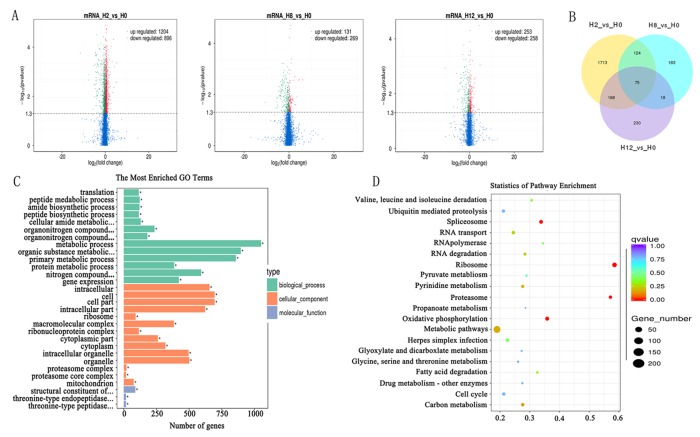
Analysis of mRNA sequencing data. Volcano plots for differential expression genes (DEGs) between H2, H8, H12, and H0, respectively. (B) Venn diagrams display the distribution of the 2,531 unique DEGs between H2, H8, H12, and H0, respectively. (C) Gene ontology (GO) analysis for all of DEGs between H2, H8, H12, and H0. X-axis represents the number of genes. The Y-axis on the left represents the GO term, and the Y-axis on the right represents GO type. The green column indicates the biological process, the red column the cellular component, and the gray column the molecular function. (D) Statistics of pathways enrichment of all DEGs between H2, H8, H12, and H0. Colors of the points refer to the q-value of the respective signaling pathway. Size of the point refers to the number of genes within each pathway.